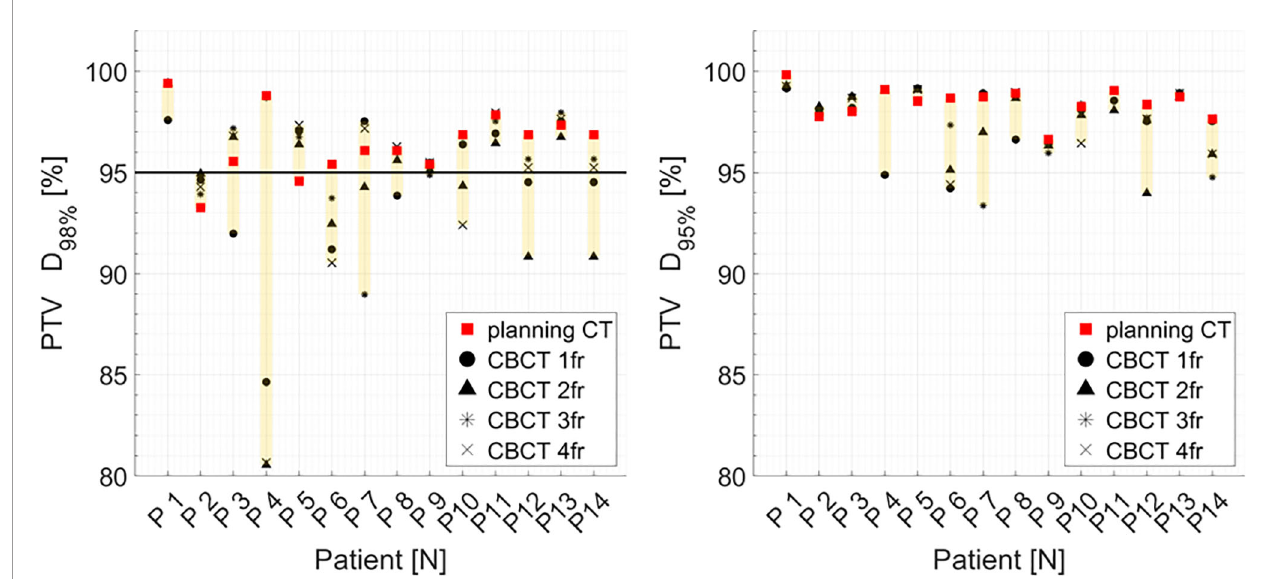
FIGURE 7 | Distribution of PTV DVH metrics (D 98% , D 95% ) for each patient at planning CT (red squares) and at each synthetic CT (sCTs) (dark markers). Colored range bars indicate the maximum variation extent within a single patient. Target coverage objective PTV D 98% ≥ 95% is indicated as a black line. CBCT, cone beam computed tomography; fr,